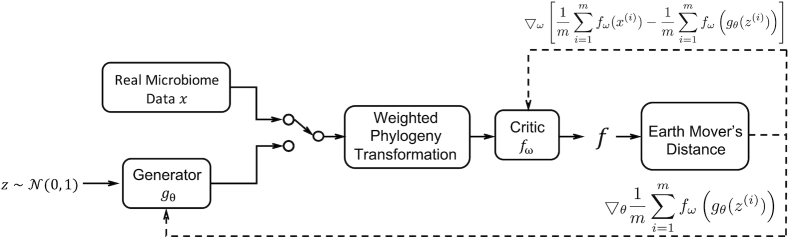
The MB-GAN network architecture. Solid lines: the Gaussian noise z is passed to the generator model gθ; both real microbiome data x and simulated microbiome data gθ(z) undergo weighted phylogeny transformation and are passed to the critic model fω; the function f calculates the Earth Mover’s distance. Dashed lines: the differentiated scores are used to update generator weights θ and critic weights ω at the ith iteration.